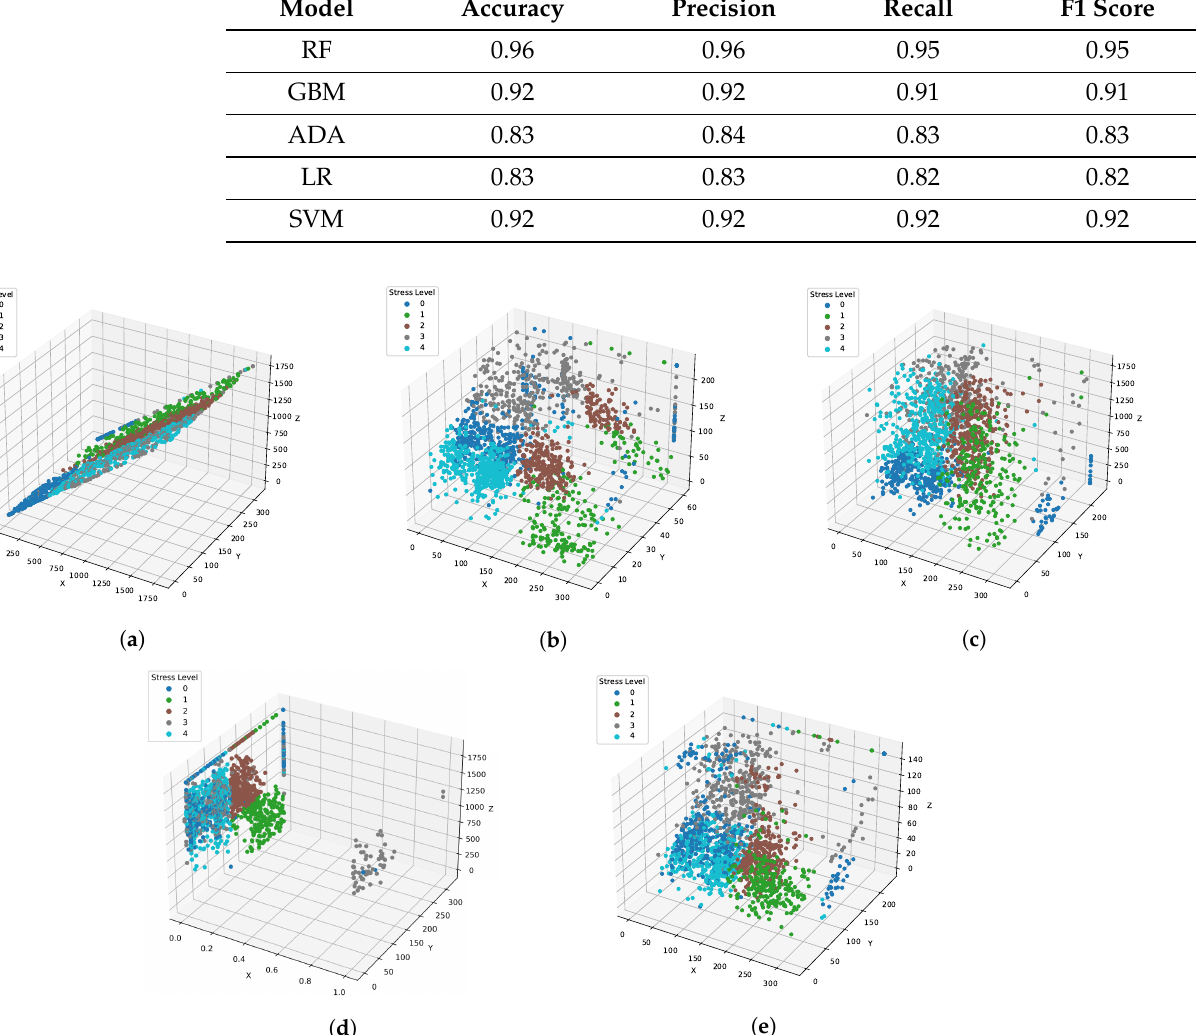
Figure 5. Feature Space using Different Feature Selection Methods. ( a ) ML. ( b ) Forward Feature Selection (FFS). ( c ) Backward Feature Elimination (BFE). ( d ) Bi-Directional Feature Elimination (BiDFE). ( e )